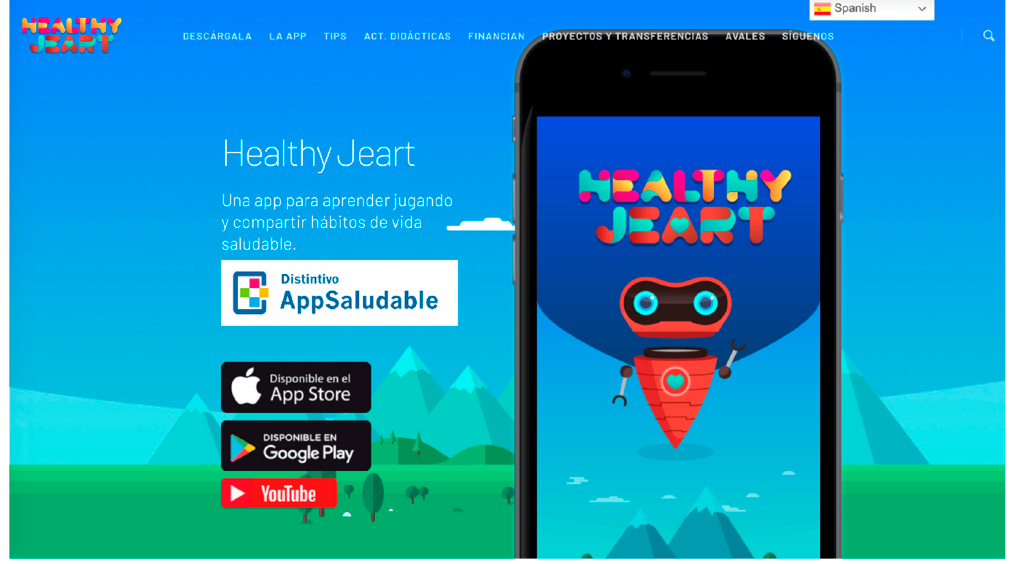
Figure 2. Mobile application available for Android and iOS. An app for learning by playing and sharing healthy lifestyle habits.